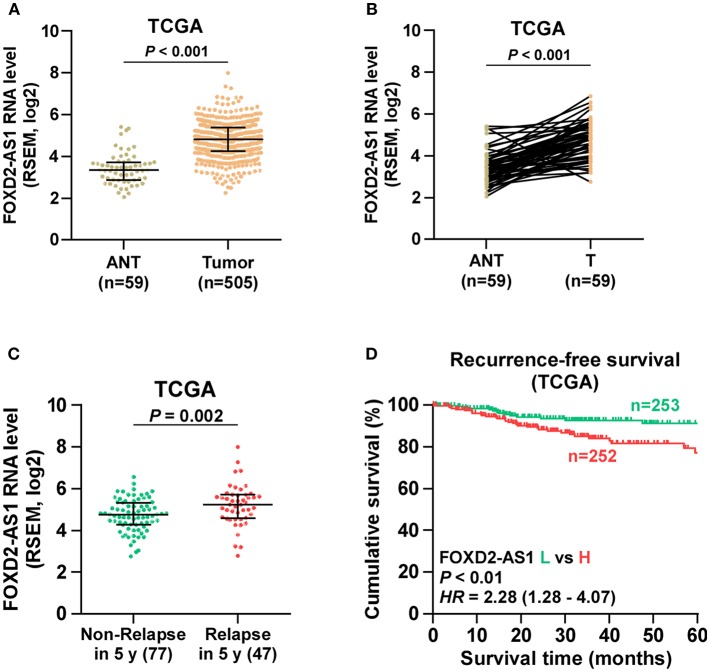
Overexpression of FOXD2-AS1 correlates with early recurrence in thyroid cancer patients. (A) FOXD2-AS1 expression in thyroid cancer tissues and the adjacent normal tissues (ANT) in the thyroid cancer dataset from TCGA. (B) FOXD2-AS1 expression in 59 paired thyroid cancer tissues and the matched adjacent normal tissues in the thyroid cancer dataset from TCGA. (C) FOXD2-AS1 expression in recurrent thyroid cancer tissues and non-recurrent thyroid cancer tissues in the thyroid cancer dataset from TCGA. (D) Kaplan-Meier analysis of FOXD2-AS1 expression in recurrence-free survival in the thyroid cancer dataset from TCGA. lncRNA FOXD2-AS1 expression levels in all thyroid cancer tissues were, respectively, normalized to that in the thyroid cancer tissue with the lowest level of lncRNA FOXD2-AS1 expression. Then, the median of lncRNA FOXD2-AS1 expression in thyroid cancer tissues was used as the cut off value to stratify high and low expression of lncRNA FOXD2-AS1.